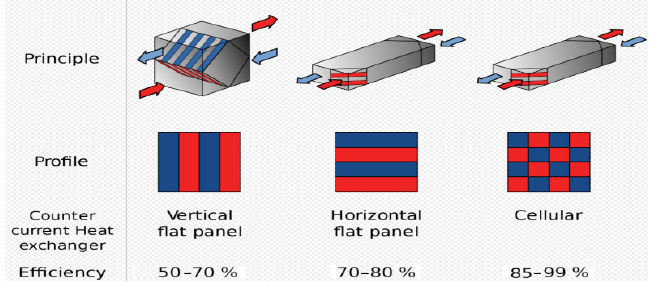
Figure 12. Plate heat recovery (data processed from Wikipedia [38]).